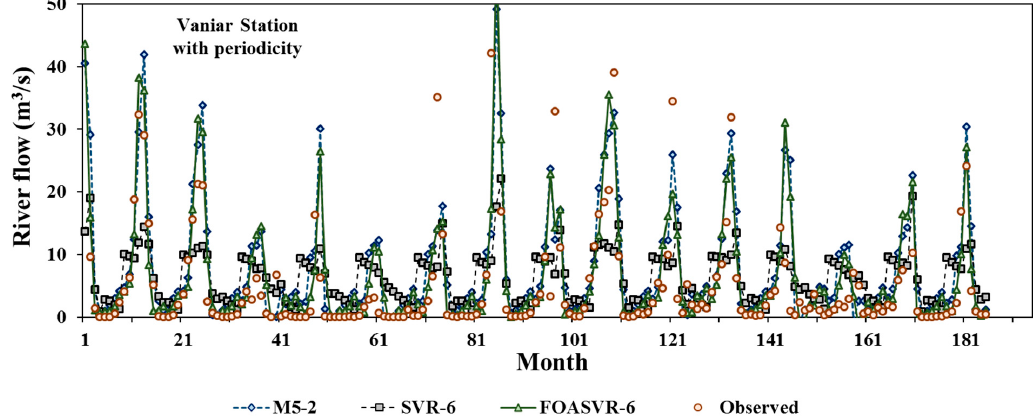
Figure 7. The observed and forecasted monthly river flows for Vaniar station without periodicity.